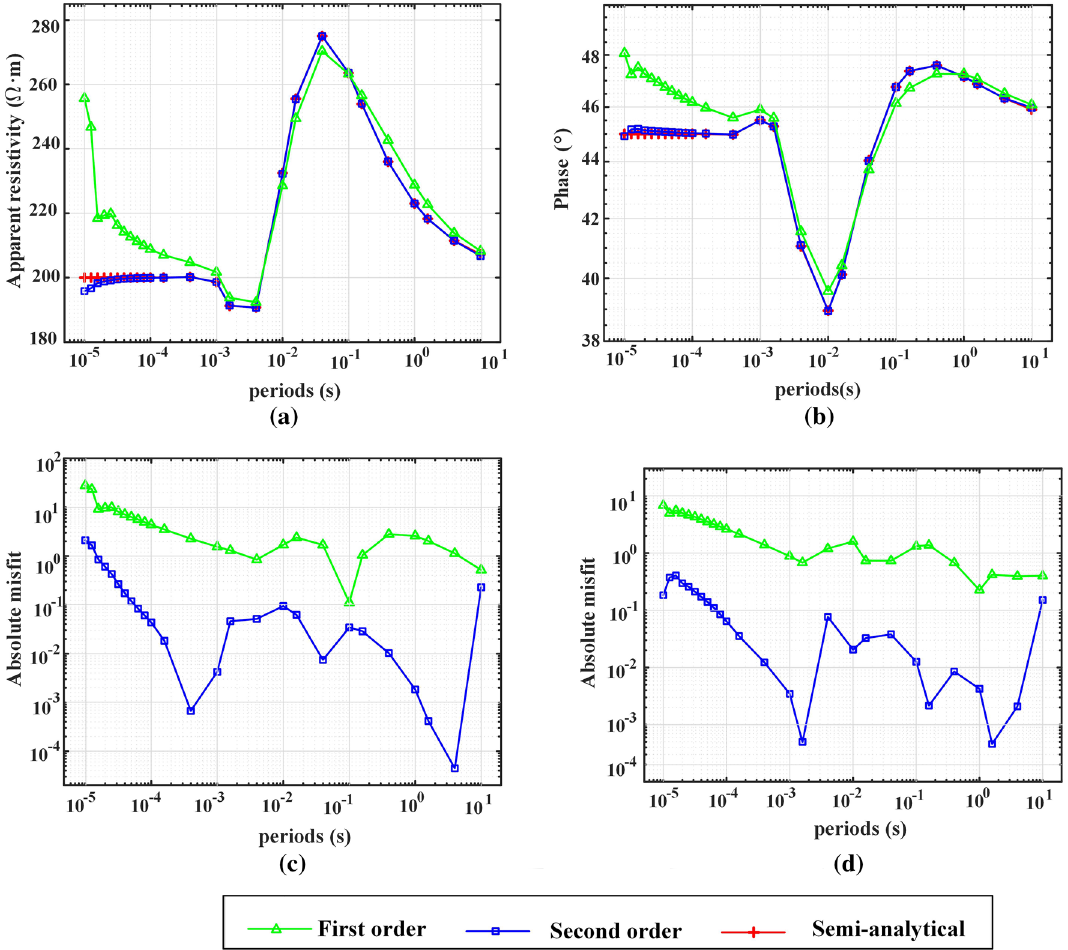
Figure 8. The MT responses of the three-dimensional layered model calculated with hybrid meshes of different orders. Apparent resistivity and phases are shown in ( a ) and ( b ), respectively. The misfits of the apparent resistivity and phases are shown in ( c ) and ( d ), respectively. The absolute misfit is normalized by the semianalytic